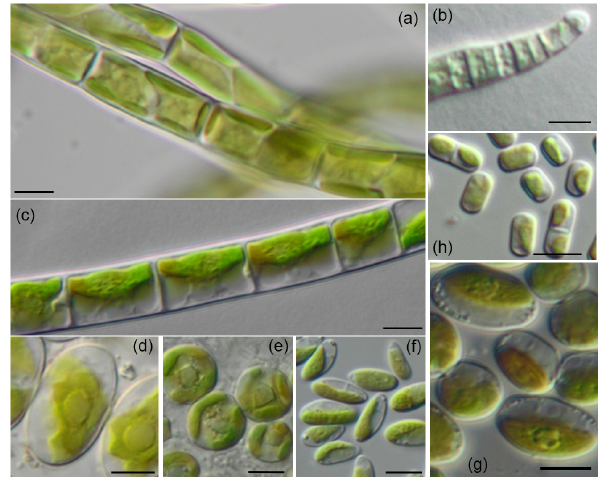
Figure 3. Filamentous and examples of coccal algae from for- est BSCs: algae with strong filaments: A- Xanthonema cf. exile , B- Microcoleus vaginatus , C- Klebsormidium cf. flaccidum ; coc- cal algae: D- Chloroidium ellipsoideum , E- Eustigmatos magnus , F- Coccomyxa simplex ; algae with short or easily disintegrated fila- ments: G- Stichococcus bacillaris , H- Interfilum paradoxum ; scale bar =